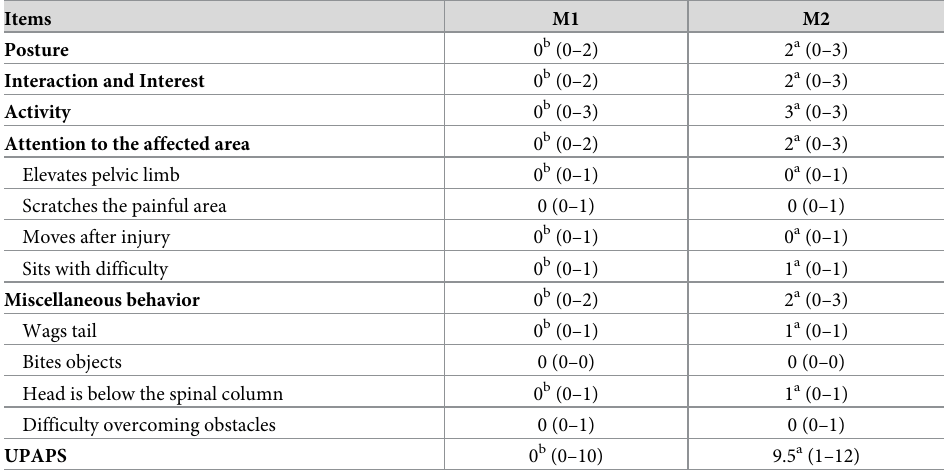
Table 8. Median (amplitude) of the UPAPS scores before and after castration in castrated piglets awake (n = 14) during the assessment. Items M1 M2 Posture 0 b (0–2) 2 a (0–3) Interaction and Interest 0 b (0–2) 2 a (0–3) Activity 0 b (0–3) 3 a (0–3) Attention to the affected area 0 b (0–2) Elevates pelvic limb Scratches the painful area Moves after injury Sits with difficulty 0 b (0–1) Miscellaneous behavior 0 b (0–2) 2 a (0–3) Wags tail 0 b (0–1) Bites objects Difficulty overcoming obstacles UPAPS 0 b (0–10) 9.5 a